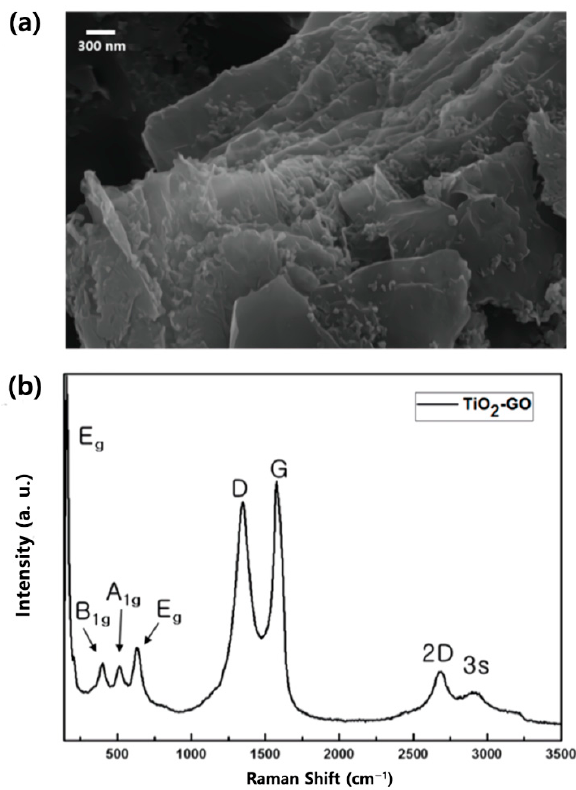
Figure 7. ( a ) FE-SEM image and ( b ) Raman spectroscopy of TiO 2 -GO composite.